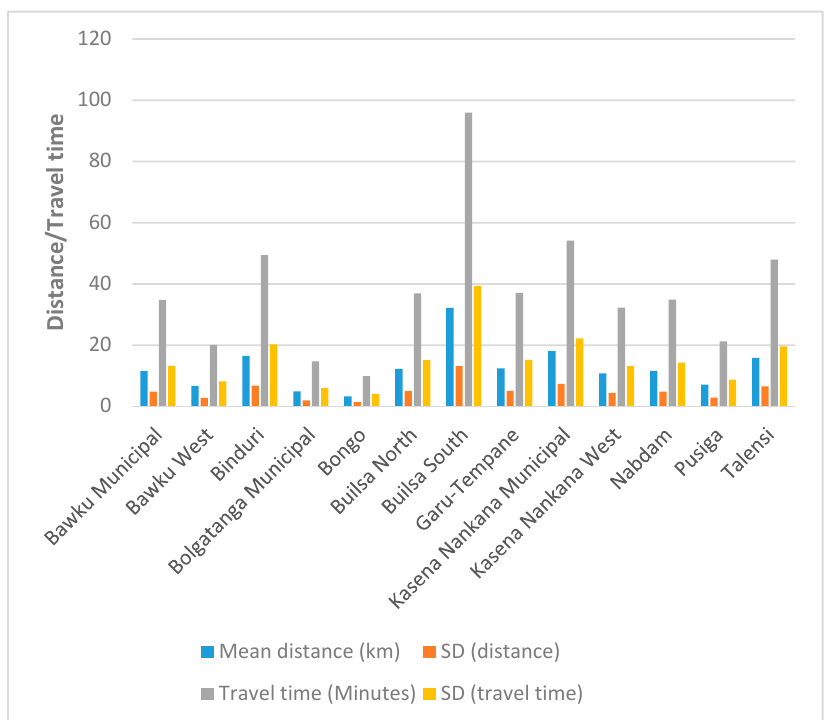
Figure 5. A bar chart depicting the mean distance and travel time from PHC clinics to the nearest health facility providing blood group and rhesus type testing services per district in the UER.